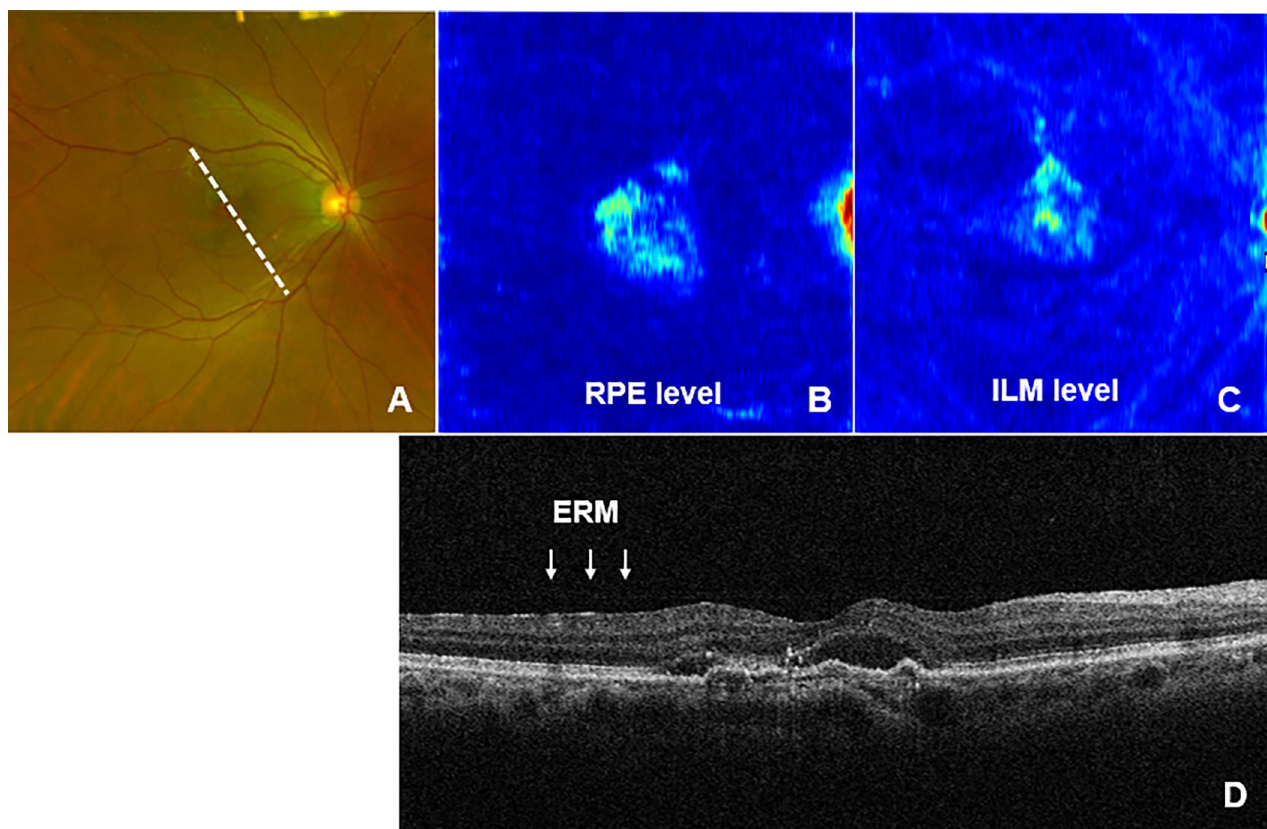
Fig 7. Ocular findings of case 1. (A) Color fundus photograph. (B) Amb-I heatmap image at RPE level. (C) Amb-I heatmap image at ILM level. (D) OCT B- scan image, scan of the white part of the dashed line in (A). Amb-I: ambiguity index, RPE: retinal pigment epithelium, ILM: internal limiting membrane, ERM: epiretinal